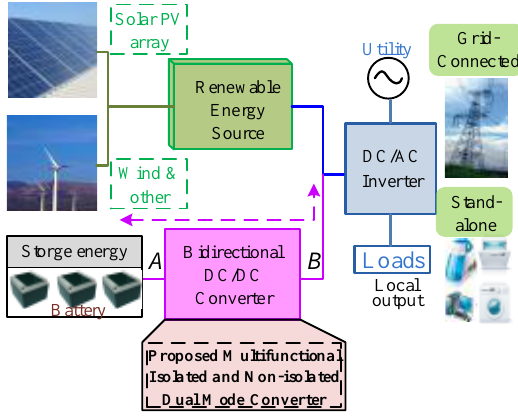
Figure 1. Block diagram of the proposed converter application system.